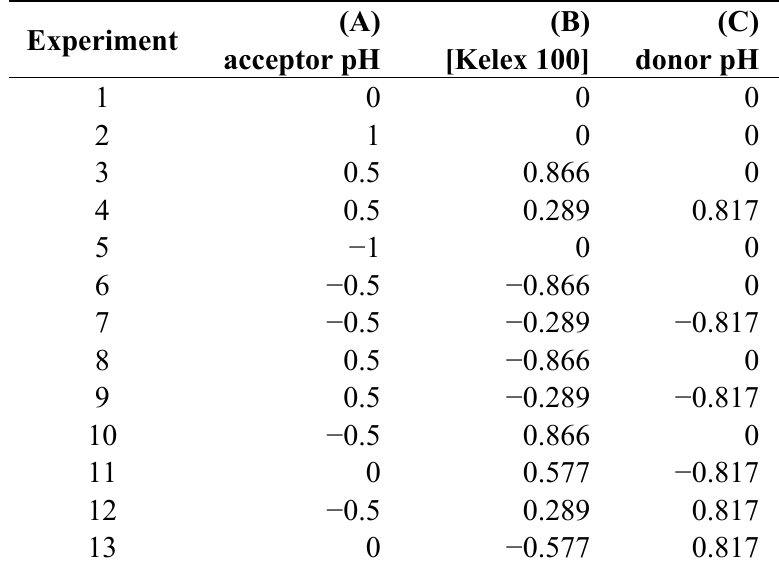
Table 1. Doehlert matrix employed for studying the simultaneous effect of the acceptor pH, donor pH, and Kelex 100 concentration on Ni(II) enrichment factor, E.